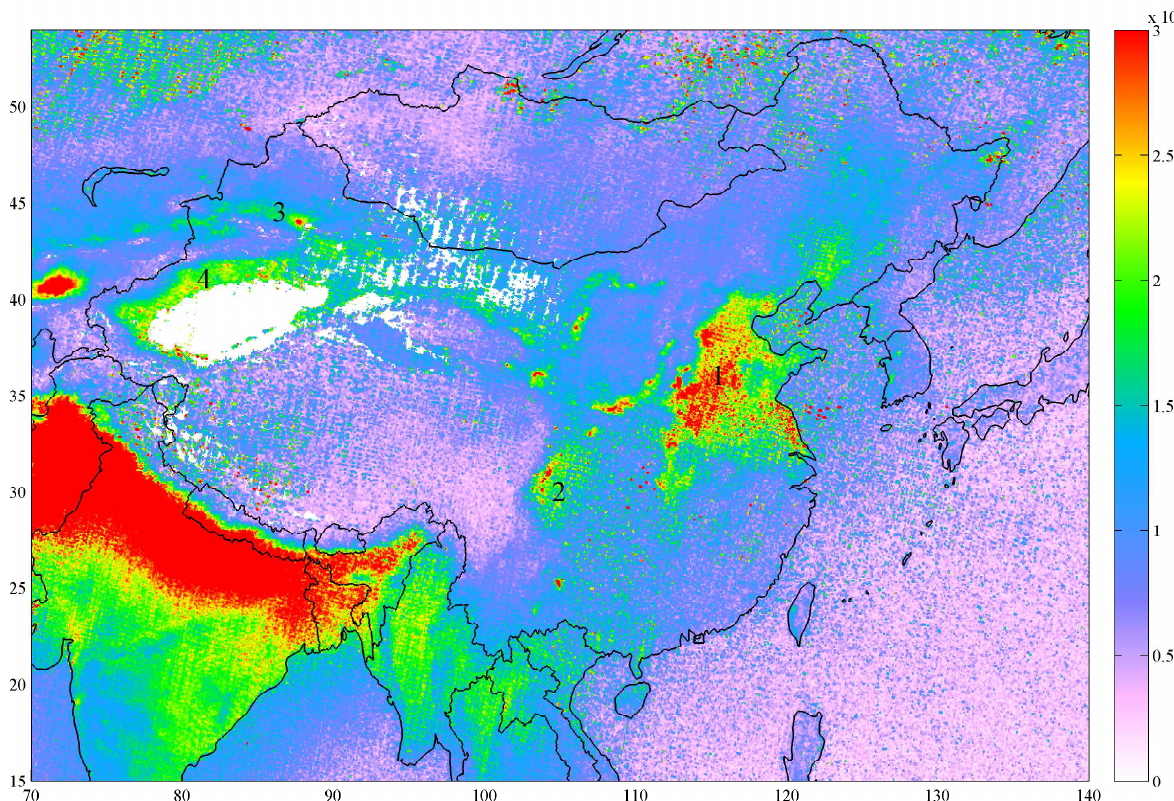
Fig. 13. NH 3 distribution over eastern Asia (moleccm − 2 ), following a griding method explicitly accounting for the IASI footprint on each individual measurement. The distribution is a five-year error-weighted average of the IASI daytime total columns in the region (a post-filtering excluding cells with less than 10 observations has been carried out over